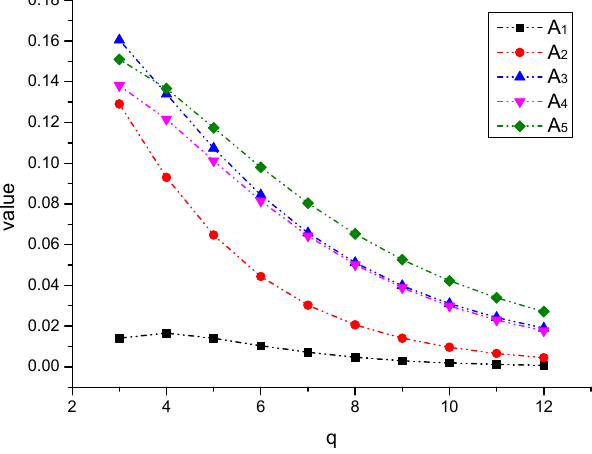
Figure 2. The influence of q -value change based on q-RONFOWA operator on the sorting result.